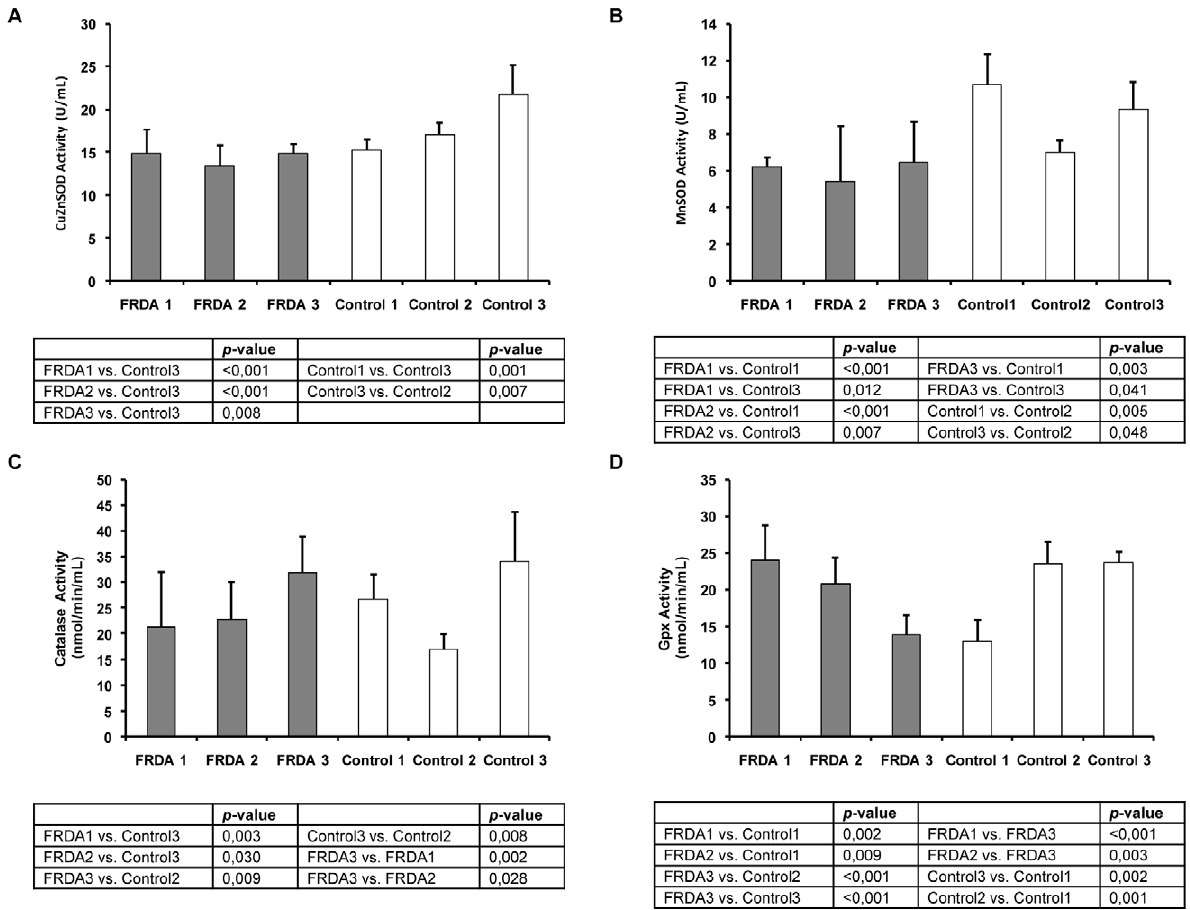
Figure 3. Analysis of anti-oxidant enzymes activities in FRDA and control cells. A. CuZnSOD activity and B. MnSOD activity evaluated using Superoxide dismutase assay kit (Cayman, Ann Arbor, MI, USA) based on the reduction of the tetrazolium salt by the superoxide to give rise formazan that can be measured at 460 nm. Results are represented as Mean ( 6 SD) of 3–4 replicates. C. Catalase activity was analyzed spectrophotometrically measuring at 540 nm the formation of the purpald-formaldehyde adduct. Results are represented as Mean ( 6 SD) of 4–8 replicates. D. Glutathione peroxidase activity determined by the Glutathione peroxidase assay kit (Cayman, Ann Arbor, MI, USA) based on the decrease of NADPH after coupling the glutathione reductase reaction, that use of the NADPH to reduce the GSSG produced by the Gpx after reducing the cumene-hydroperoxide reagent. All measures were made in FRDA fibroblasts from patients (FRDA1, FRDA 2, and FRDA 3) and three control cell lines (Control1, Control2, and Control3). Results are represented as Mean ( 6 SD) of 3–5 replicates.